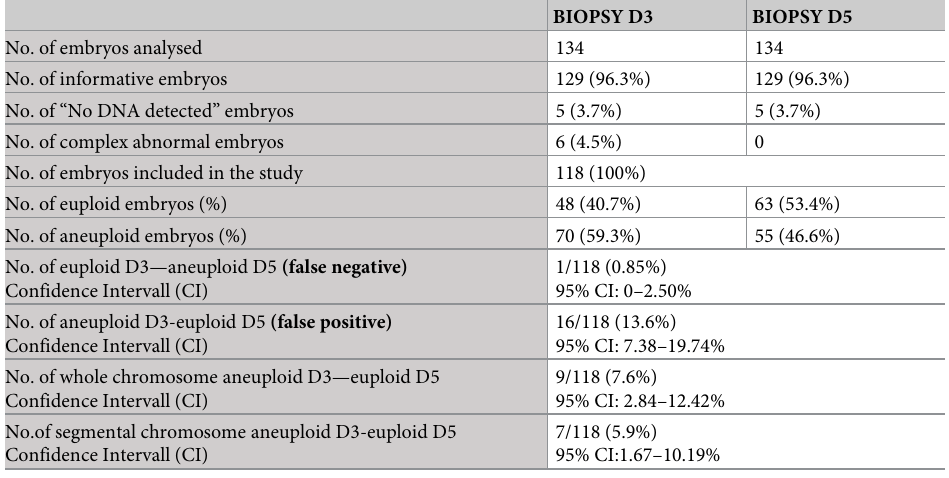
Table 2. Summary of the analysed embryos.